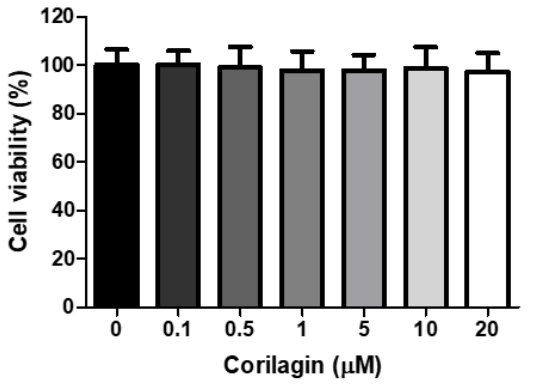
Figure 1. Cell viability of A549 cells . A549 cells were treated with different concentrations of corilagin (0, 0.1, 0.5, 1, 5, 10, and 20 µ M) for 24 h. The results are presented as a percentage of the control and expressed as the mean ±